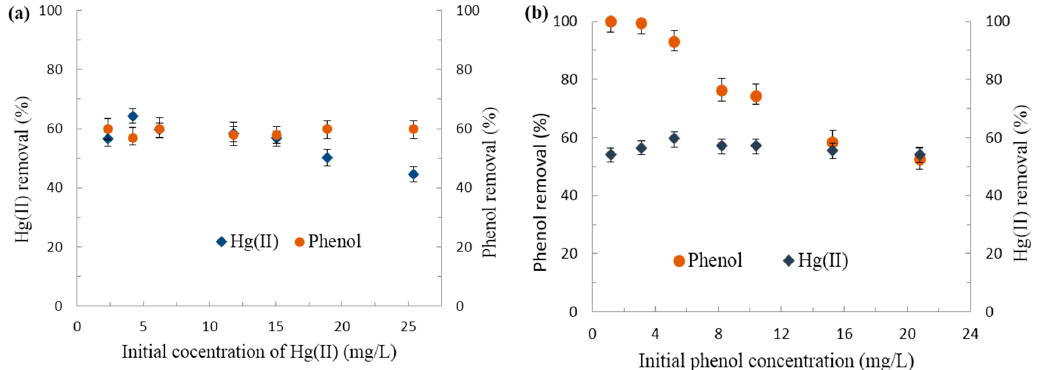
Figure 7. The concentration dependence removal of ( a ) Hg(II) in presence of ~10 mg/L phenol (Initial (Hg(II)) concentration: 1–25 mg/L, pH: 5.0, solid dose: 2.0 g/L, contact time: 12 h) and ( b ) phenol in presence of ~10 mg/L Hg(II) (Initial (phenol) concentration: 1–20 mg/L, pH: 5.0, solid dose: 2.0 g/L, contact time: 12 h).